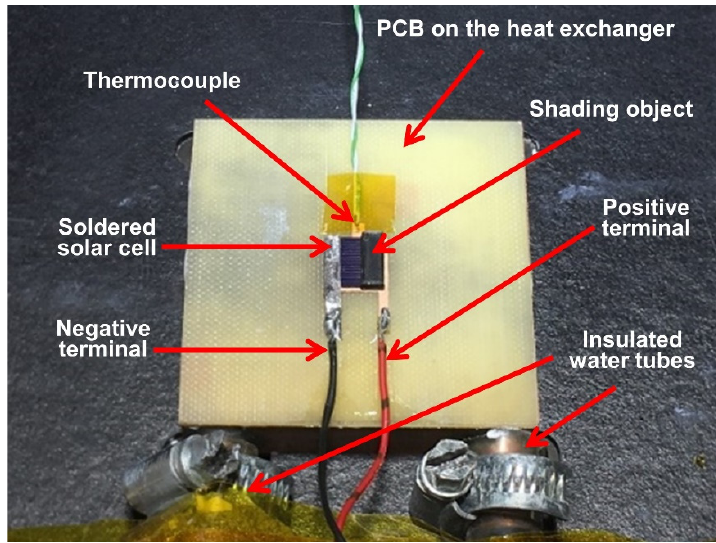
Figure 2. The solar cell testing assembly with the water-cooling system, showing the cell under light irradiation and partial shading. irradiation and partial